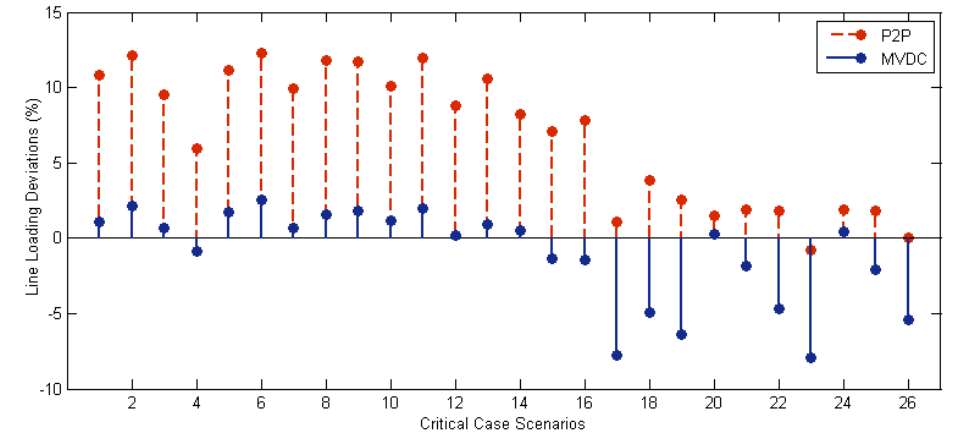
Figure 11. The comparison of loading deviations from the base case.